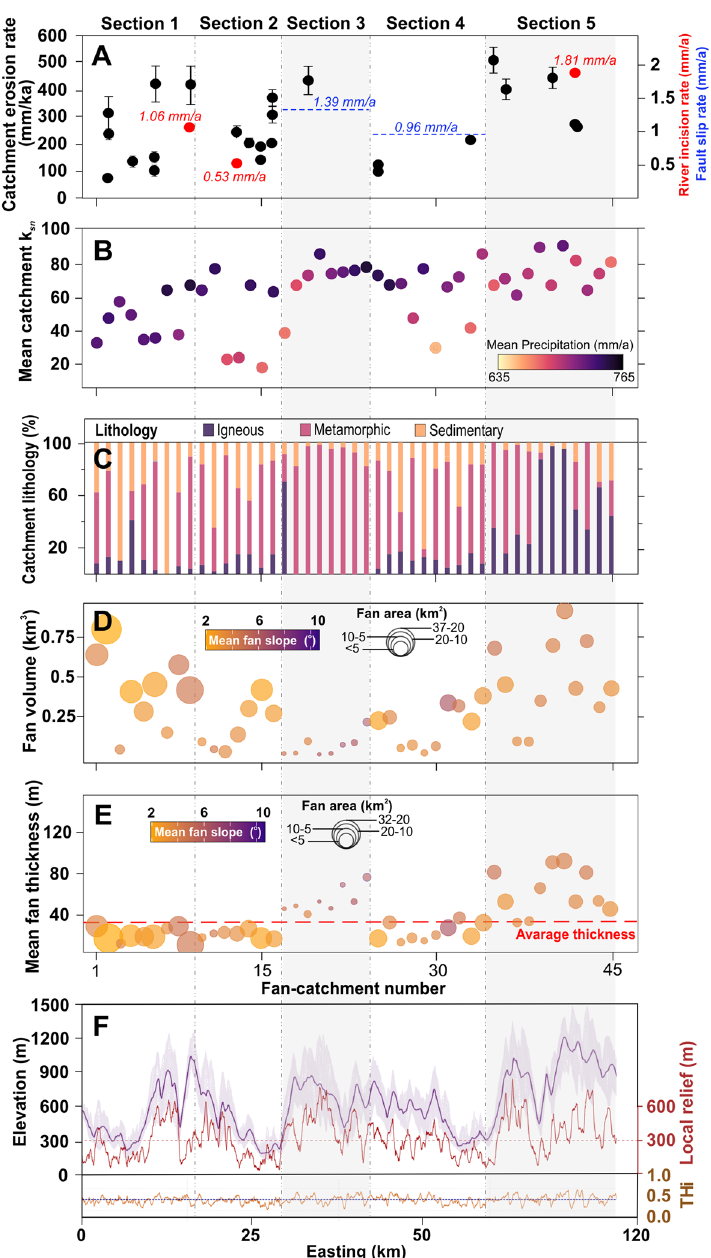
Figure 3. ( A ) The river incision (red dots), catchment-wide erosion rates (black dots), and fault slip rates (blue dots). ( B ) The mean catchment k sn and mean annual precipitation. ( C ) Relative cumulative proportions of the catchment lithologies. ( D ) Estimated alluvial fan volume, area, and slope. ( E ) Alluvial fan thickness, area, and slope. The dashed red line shows the mean alluvial fan thickness. ( F ) Local relief within a 1-km-radius circular moving window. THi transverse hypsometric integral. See Fig. 1B for the locality of the swath profile. The dashed black line shows sections and the grey shaded color marks a higher rock uplift rate relatively (see the text for